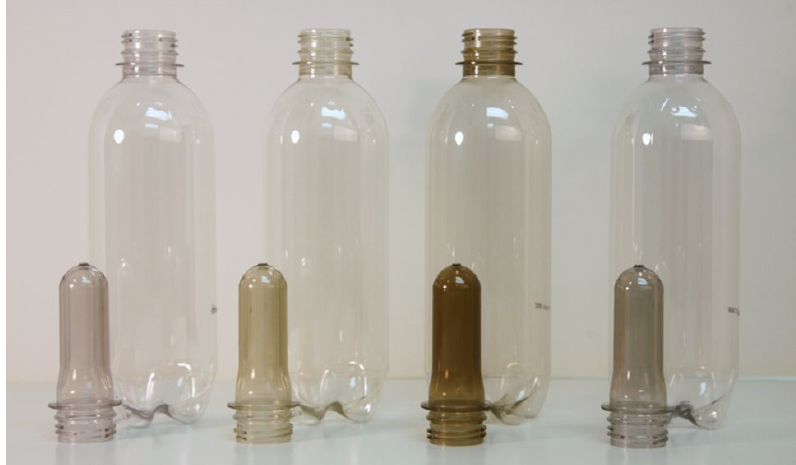
Figure 14. PCR preform color variation (image courtesy of Amcor).